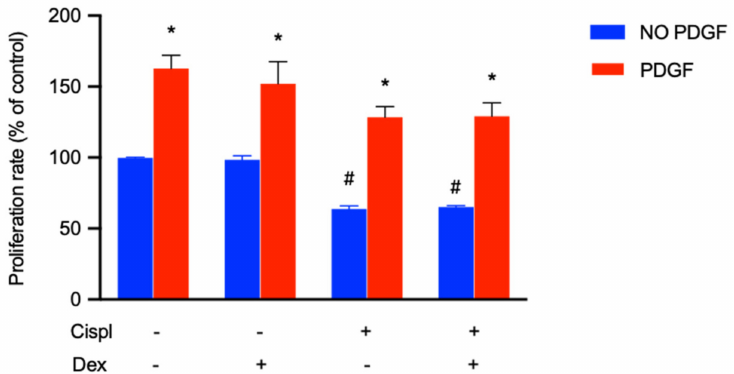
Figure 5. The effect of the treatment for 48 h with PDGF-BB (10 ng/mL) in the presence of cisplatin (30 µ M) with or without dexamethasone (10 nM) on BCPs was evaluated by MTT assay. The values are expressed as the mean ± SD of results from three independent experiments, with four parallel samples for each group in each experiment. * p < 0.05 vs. cells with the same treatment in the presence of PDGF; # p < 0.05 vs. control cells (no treated cells) without PDGF. The non-parametric Mann-Whitney test was used for pairwise